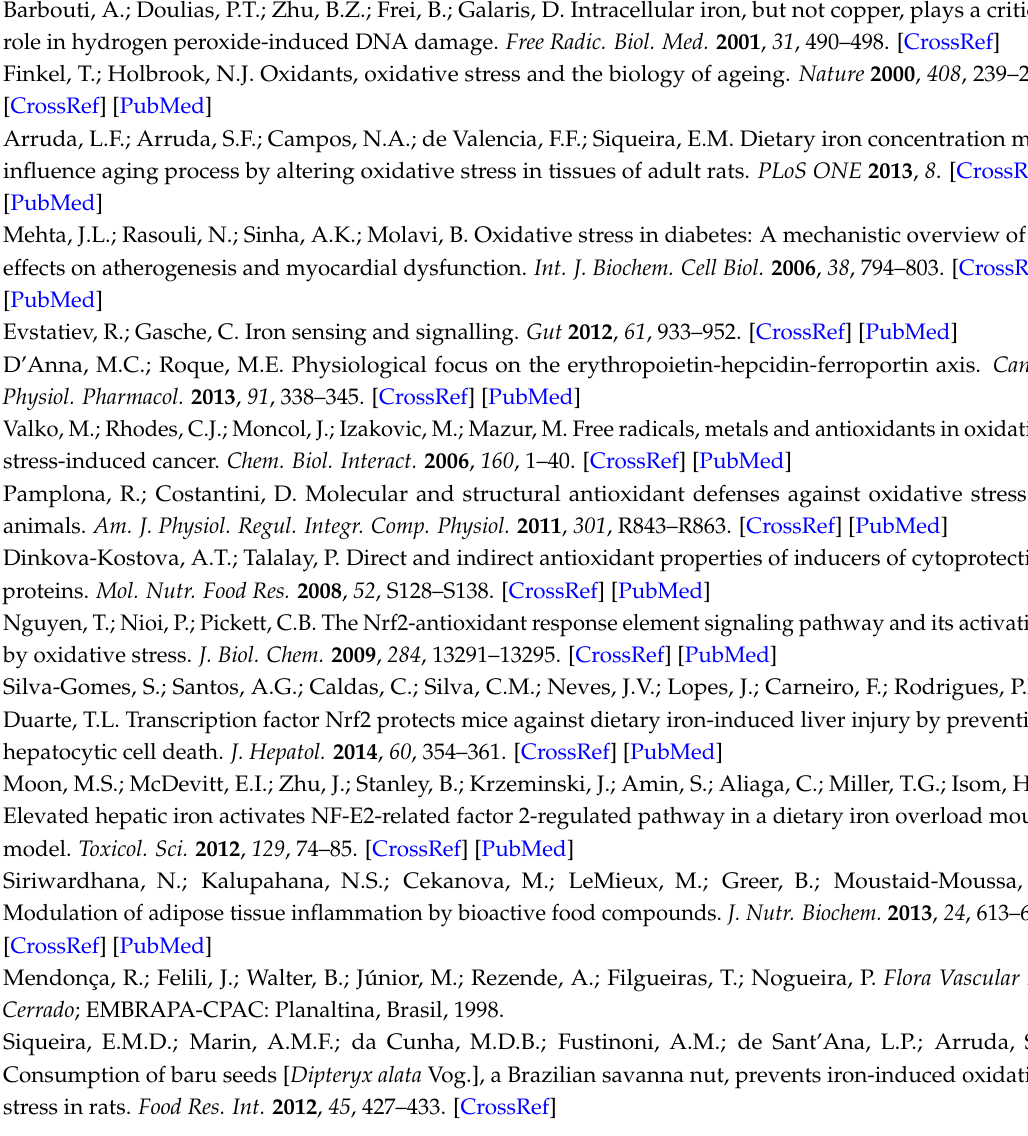
Supplementary Materials: The following are available online at www.mdpi.com/link, Table S1: Dietary compositions, Table S2: Primer sequences used for Bmp6, Cat, Ftl, Hamp, Hmox1, Nqo1, Nrf2 and Actb real-time PCR